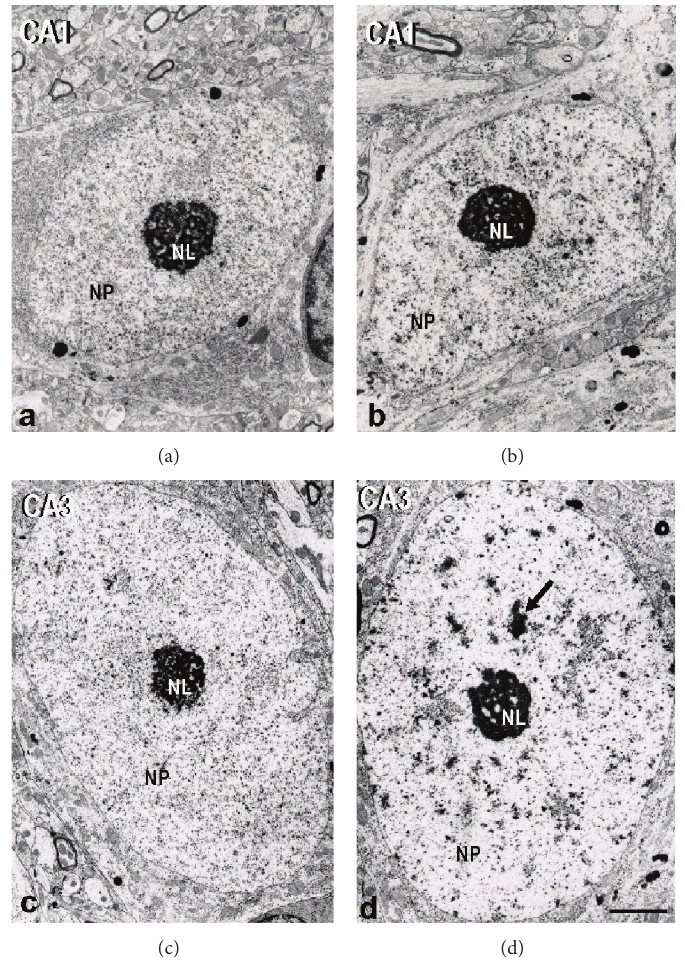
Figure 2: Electron micrographs of pyramidal neuron nuclei in the hippocampus of control and stressed male tree shrews: (a), control CA1; (b), stress CA1; (c), control CA3; (d), stress CA3. Note the homogeneous nucleoplasma (NP) in the controls and the large number of heterochromatin clusters (arrow) in nuclei of CA3 pyramidal neurons in stressed animals. NL: nucleolus. Calibration bar: 2 𝜇